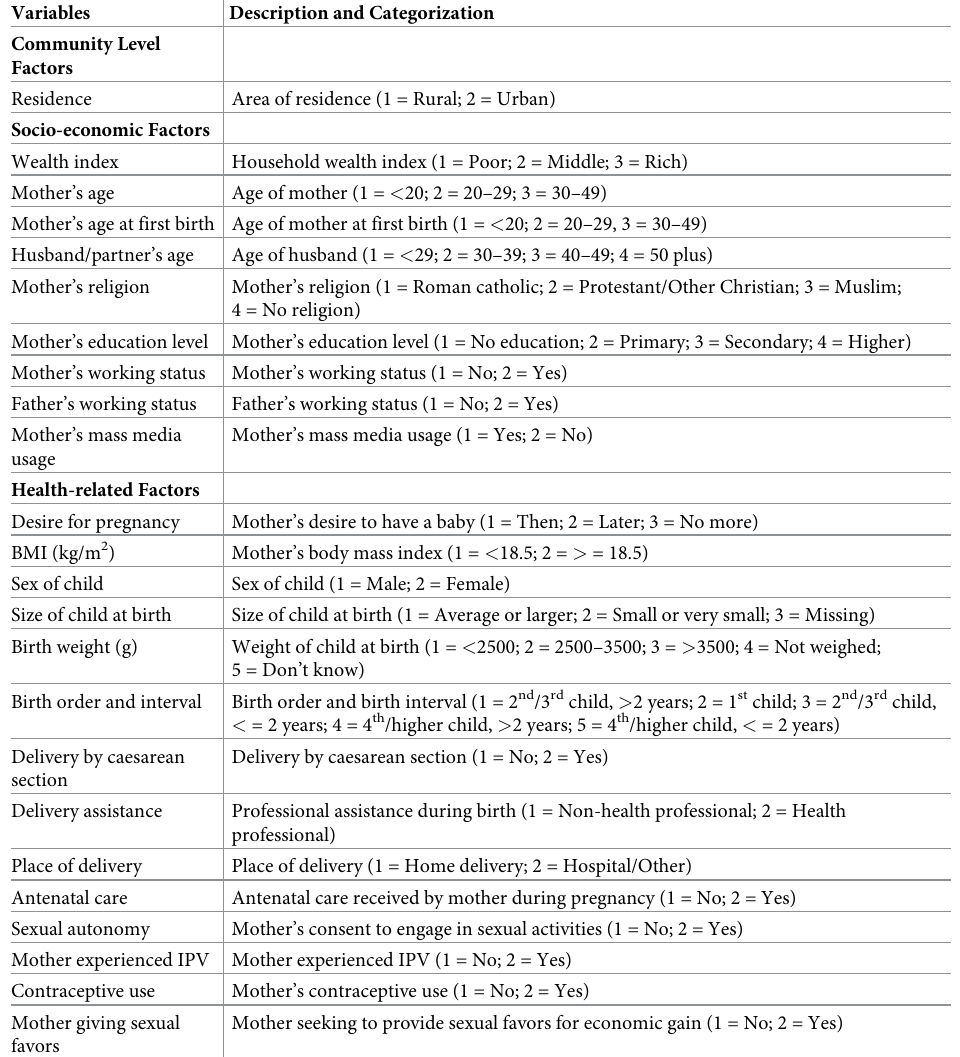
Table 2. Variable description and